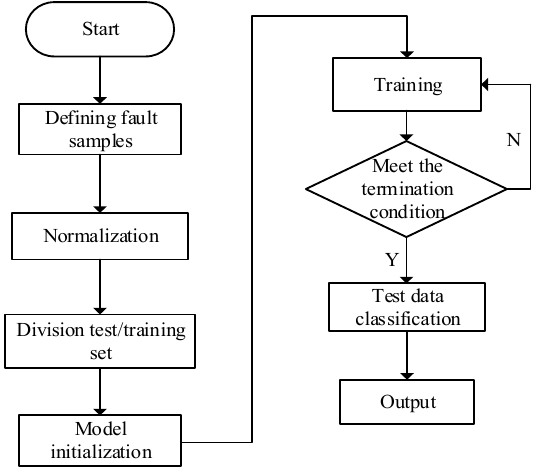
Figure 10. Flowchart of the program.